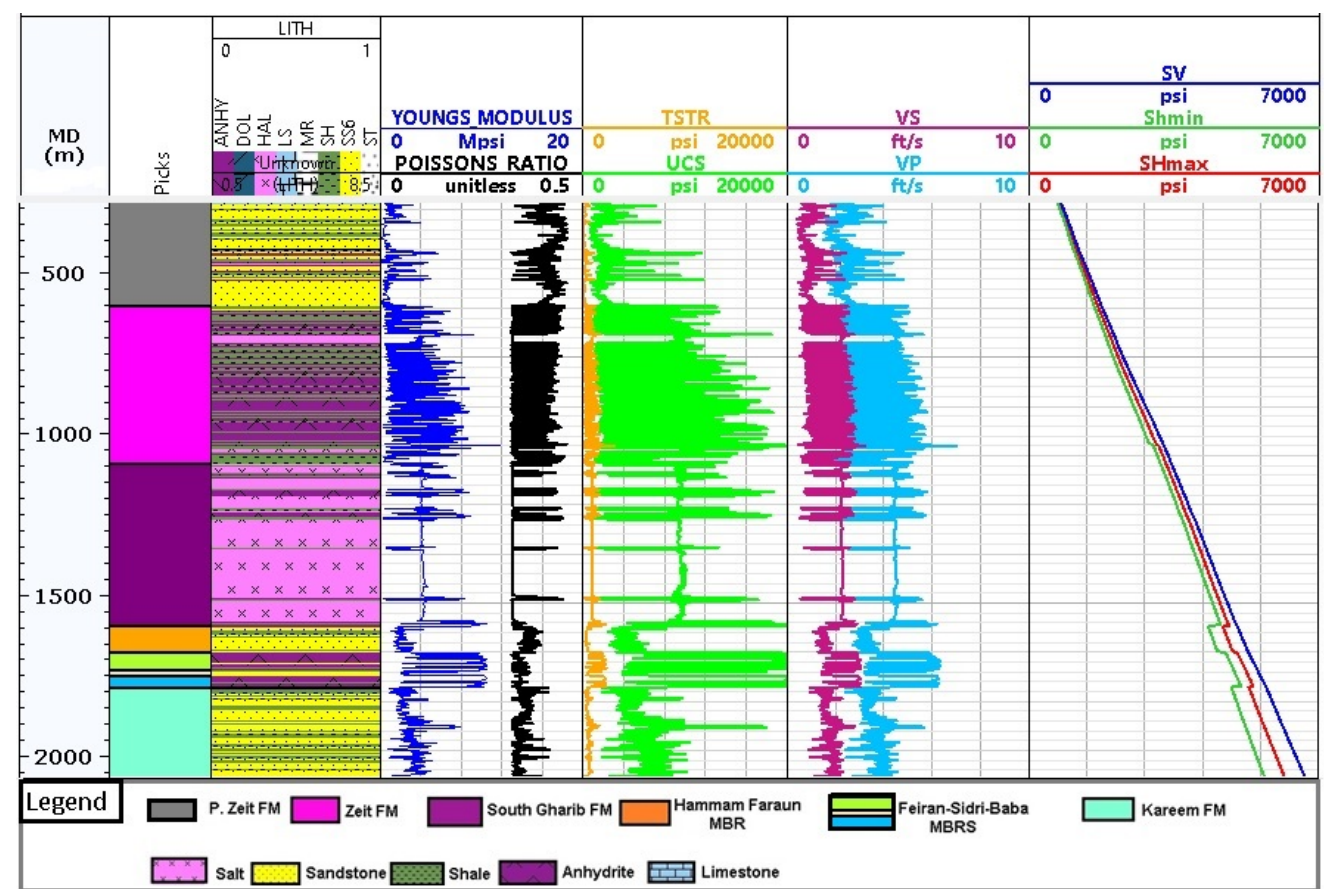
Figure 7. The mechanical properties model and in situ stresses for El Morgan-A1 well. Track 1 (Depth), Track 2 (Picks), Track 3 (Lithology), Track 4 (Youngs Modulus and Poisson ration), Track 5 (tensile strength and USC), Track 6 (VP, VS), Track 7 (Vertical stress, Shmin, SHmax). Table 3. The developed in situ stresses and depth-of-damage values of El Morgan oil field. Sv Magnitude Shmin Magnitude SHmax